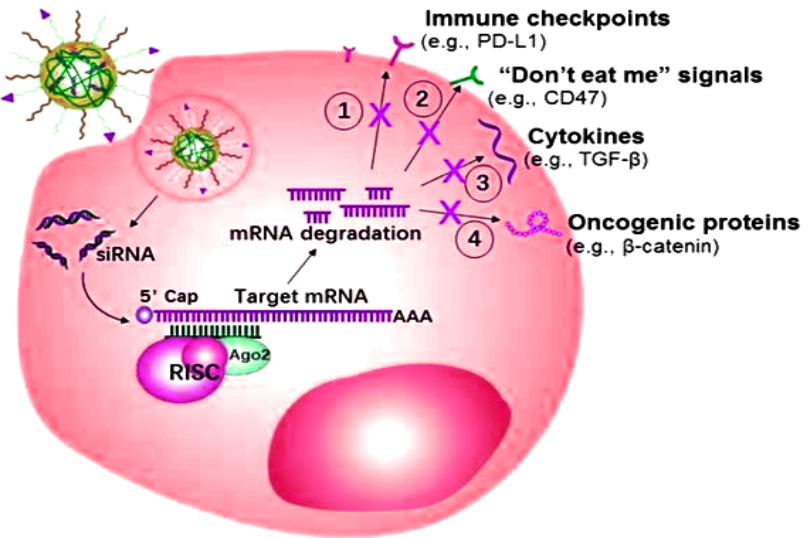
Figure 5. Small interfering RNAs (siRNA) mechanism of action for overexpressing the specific genes of the related cancers. Table 2. Summary of RNA-based nanostructures in treatment of